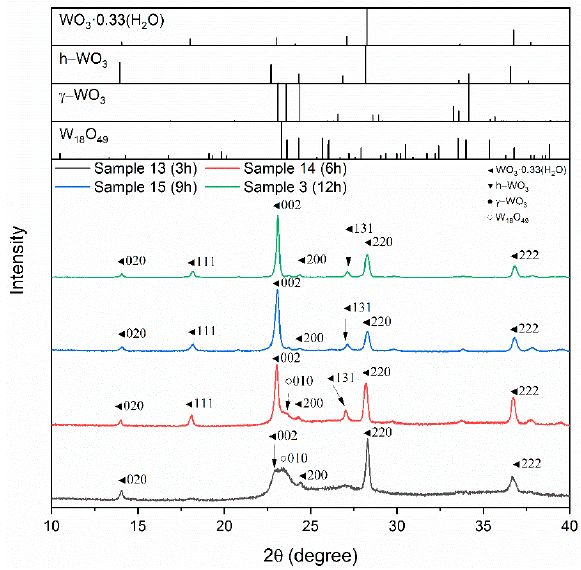
Figure 8. XRD spectra of samples that are synthesized at a temperature of 200 °C, but for 3 h (sample 13), 6 h (sample 14), 9 h (sample 15), and 12 h (sample 3). The top inset is the standard reference di ff raction pa tt erns of W 18 O 49 (JCPDS no. 36-0101), h-WO 3 (JCPDS no. 75-2187), WO 3 ·0.33(H 2 O) (JCPDS no. 87-1203), and γ -WO 3 (JCPDS no.